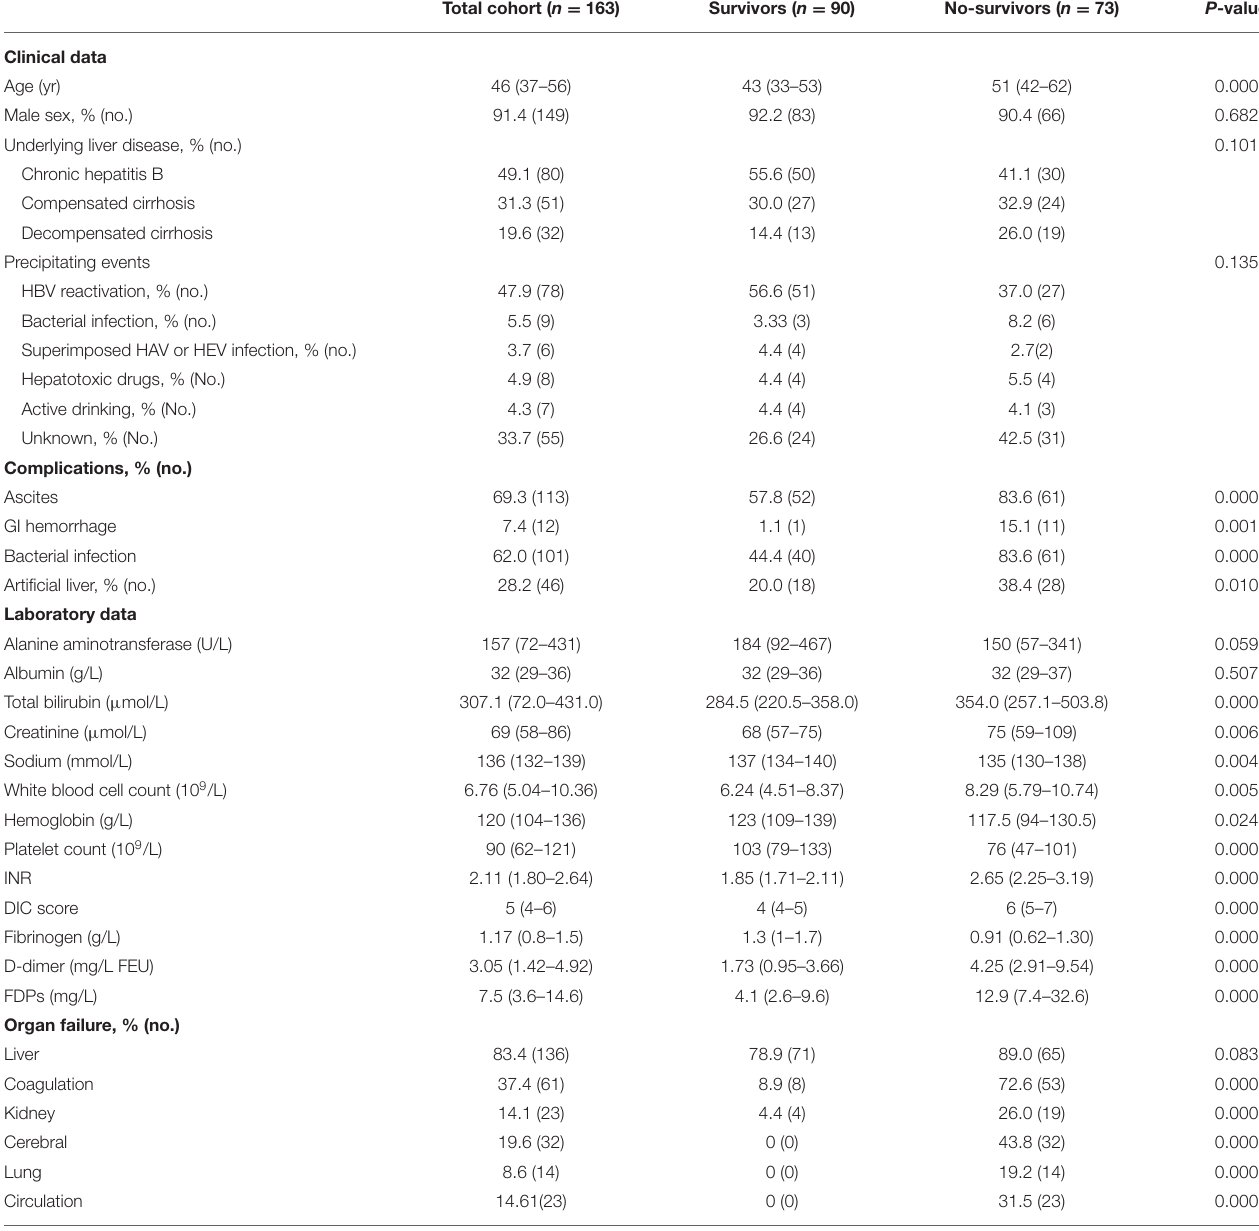
TABLE 1 | Clinical characteristics of patients with